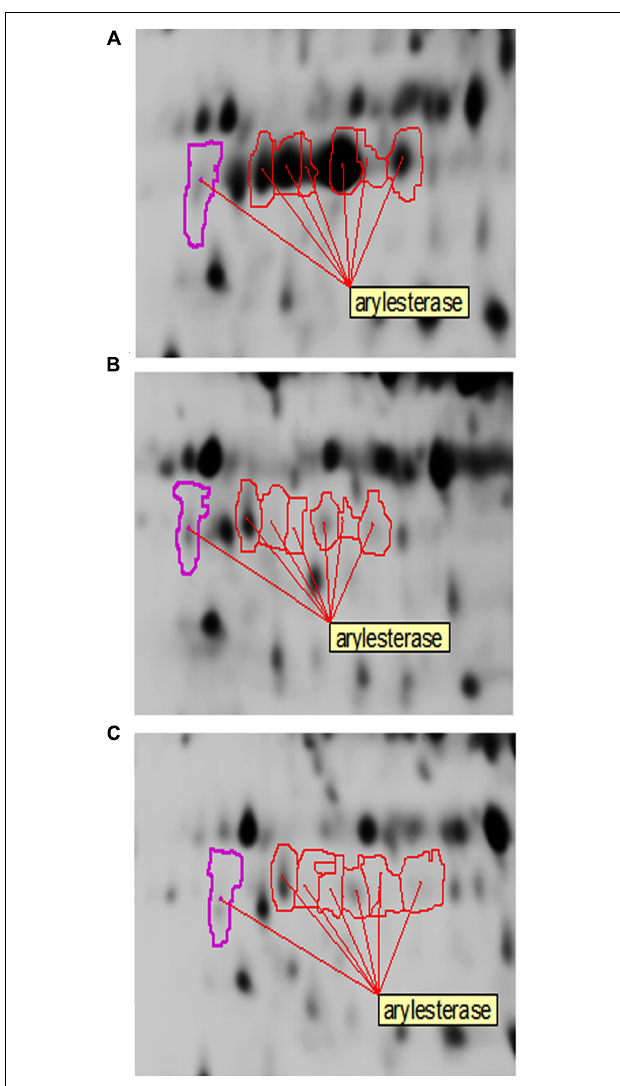
FIGURE 7 | Changes of arylesterase isoforms of A. senegalensis LMG 23690 T acclimated to different carbon sources. (A–C) Show equivalent regions of 2-DiGE gel separations of CyDye-labeled proteins obtained from cells acclimated to ethanol, glucose and a mixture of glucose and acetic acid,